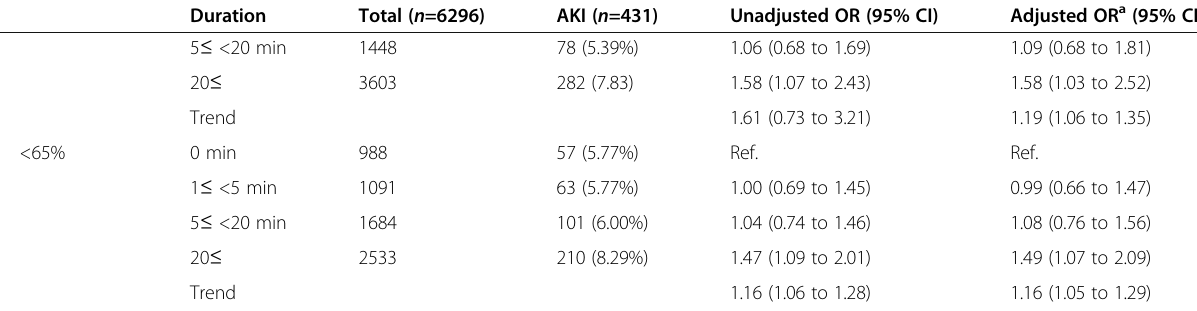
Table 2 Univariable and multivariable associations between absolute or relative thresholds and acute kidney injury ( N =6296) (Continued)